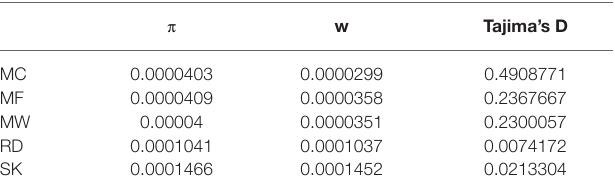
TABLE 1 | The genetic diversity index for three populations of Père David’s deer and its related